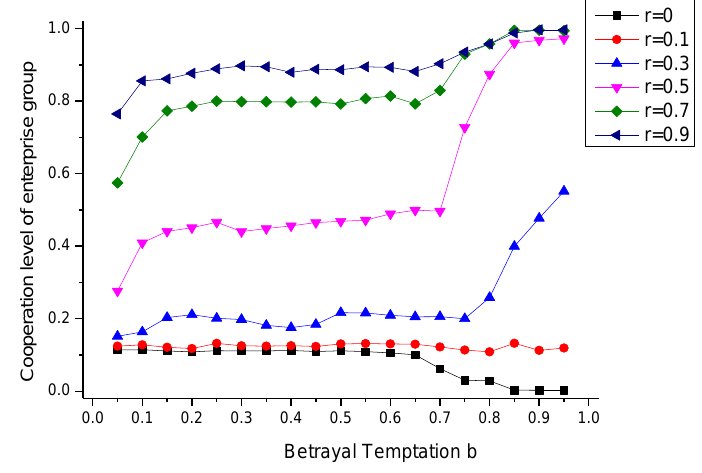
Figure 4. The evolutionary equilibrium under different supervision intensity.